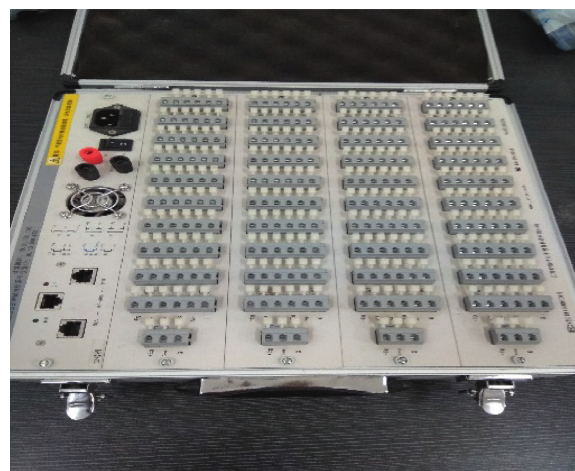
Figure 2: Static strain test analyzer instrument.